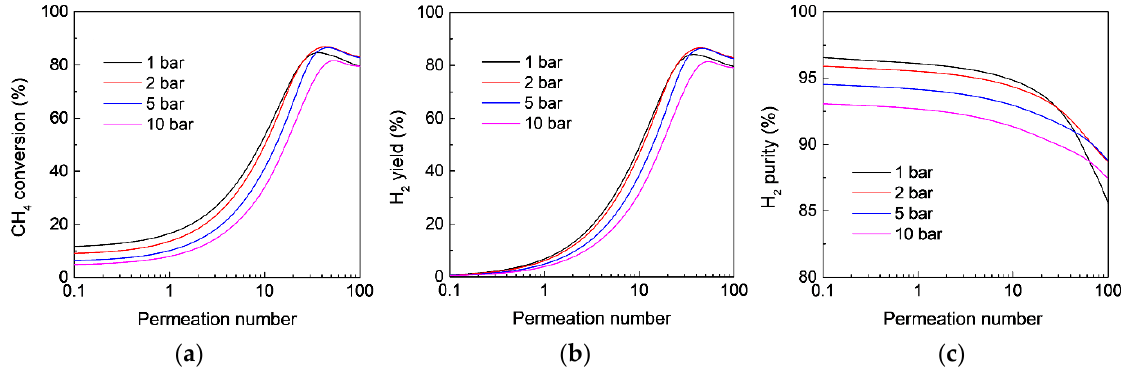
Figure 8. Effect of CH 4 feed pressure on ( a ) CH 4 conversion, ( b ) H 2 yield, and ( c ) H 2 purity as a function of the permeation number for MDA in the membrane reactor. (Simulation conditions: T = 973 K, Da = 5; α H = 200, α CH 4 / C 6 H 6 = Knudsen selectivity, p l = 0.05 bar).